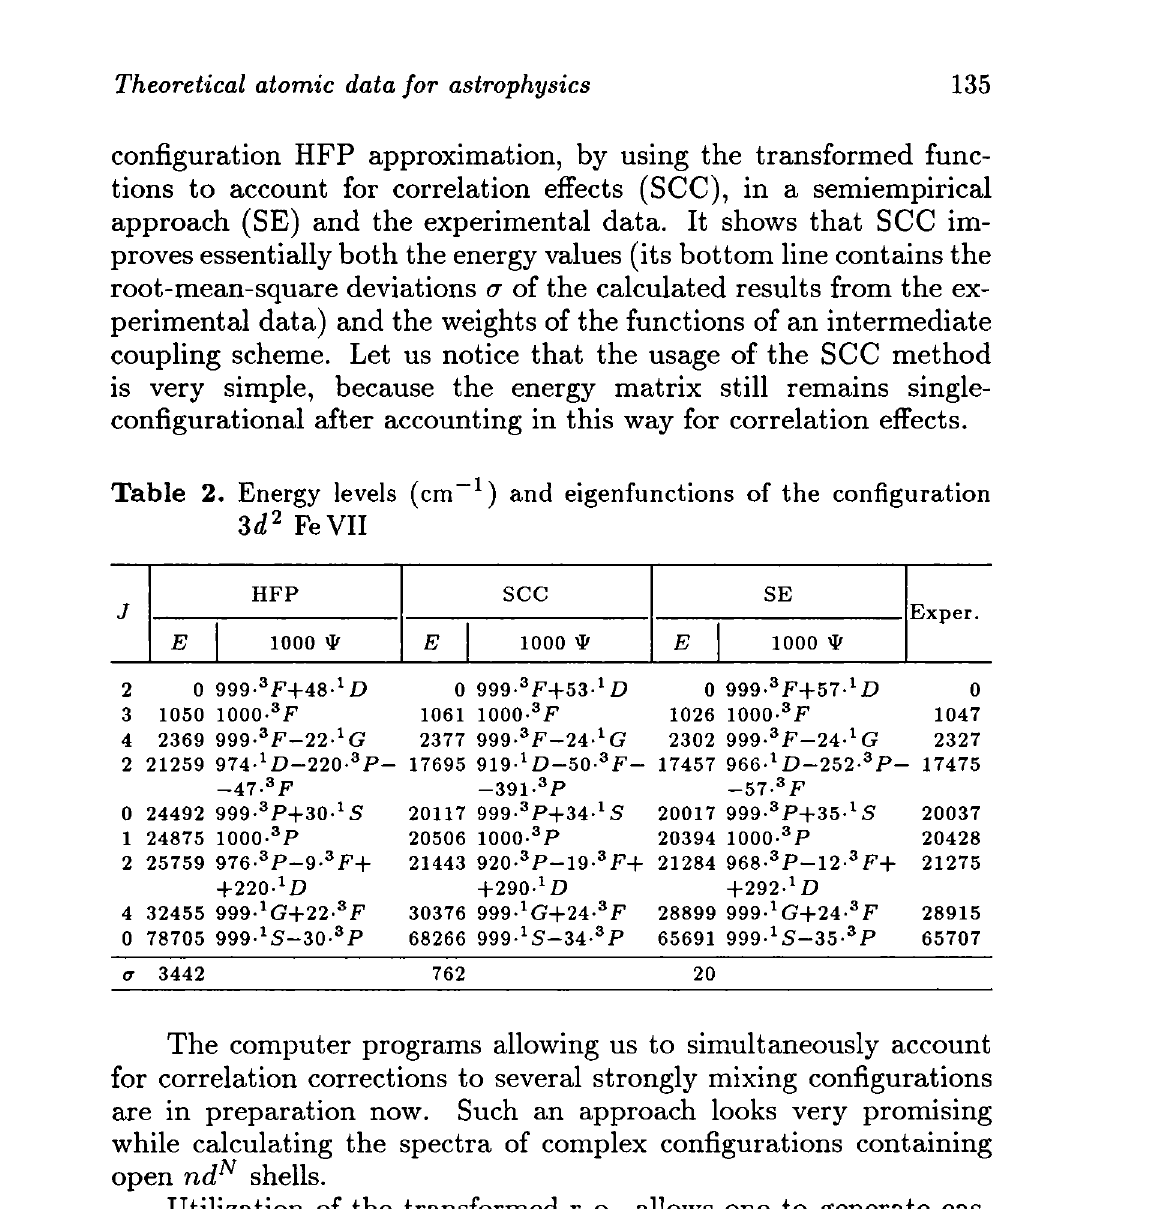
Table 2. Energy levels ( c m -1 ) and eigenfunctions of the configuration 3d 2 Fe